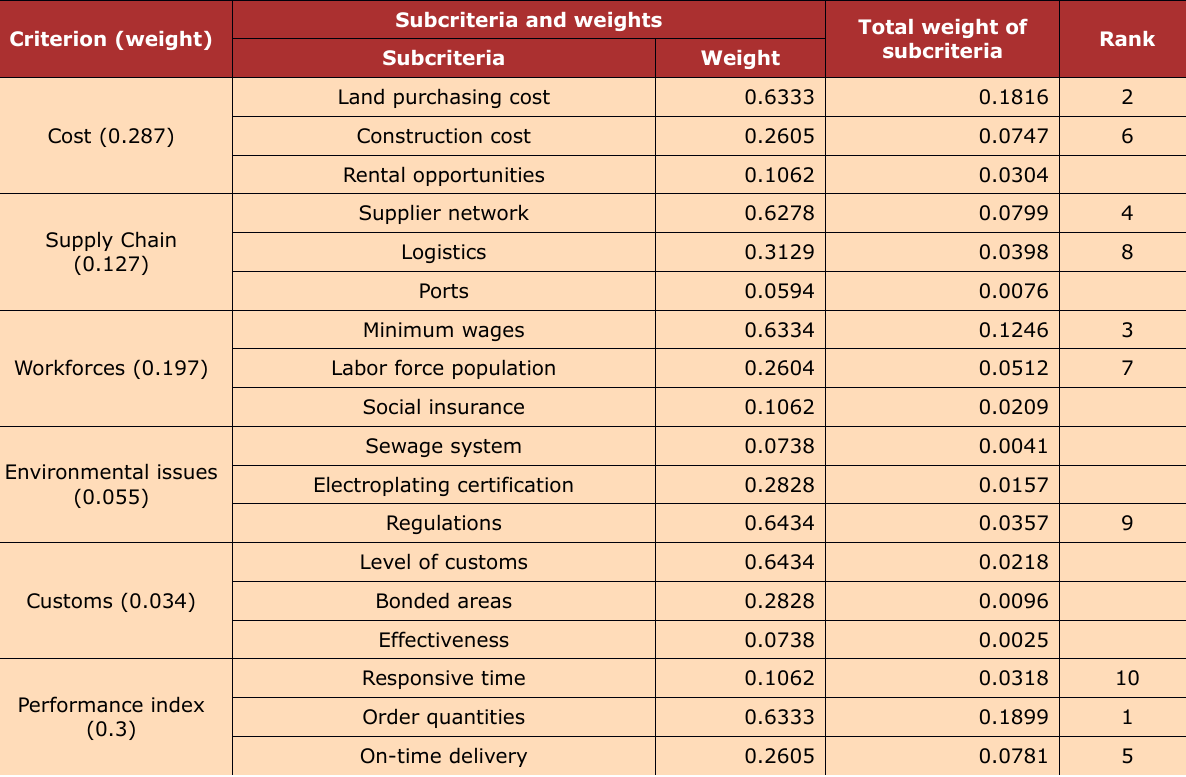
Table 4. The ranking of the